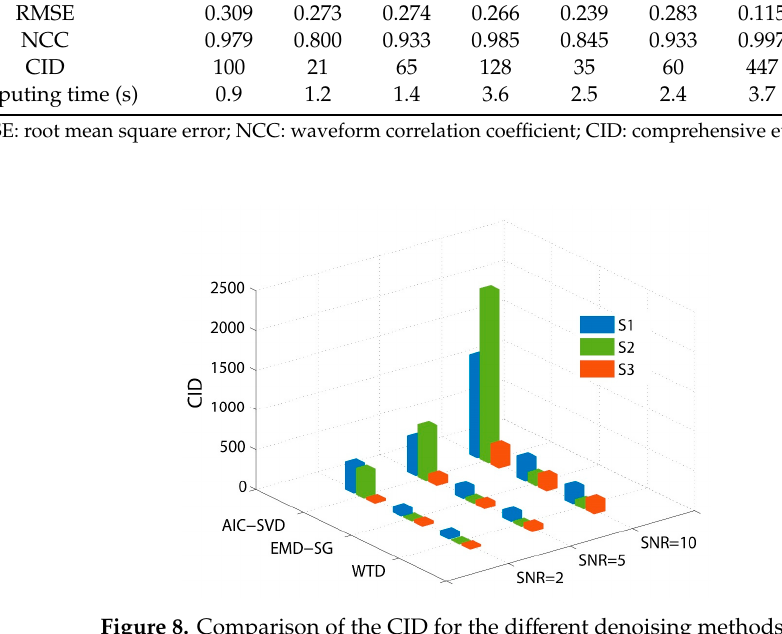
Figure 8. Comparison of the CID for the di ff erent denoising